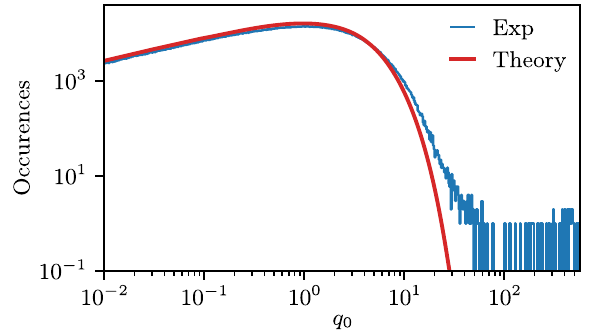
FIG. 6. Distribution of the discovery test statistic is plotted in blue on a logarithmic scale from 10 − 2 onward. The red curve shows the expected distribution given the theoretical probability distribution function of q 0 for the total number of axion masses tested, assuming that each mass constitutes an independent test. As discussed in the main text, this is only approximately true. A vast majority of the axion masses tested have q 0 < 0 . 01 and are for clarity not shown. Masses with q 0 > 10 comprise less than 0.5% of all masses tested. We do not explicitly account for the look-elsewhere effect in this plot. As we note in the main text, a 5 σ significance for rejecting the null hypothesis will correspond to a q 0 here of 52.1 after taking into account the look-elsewhere